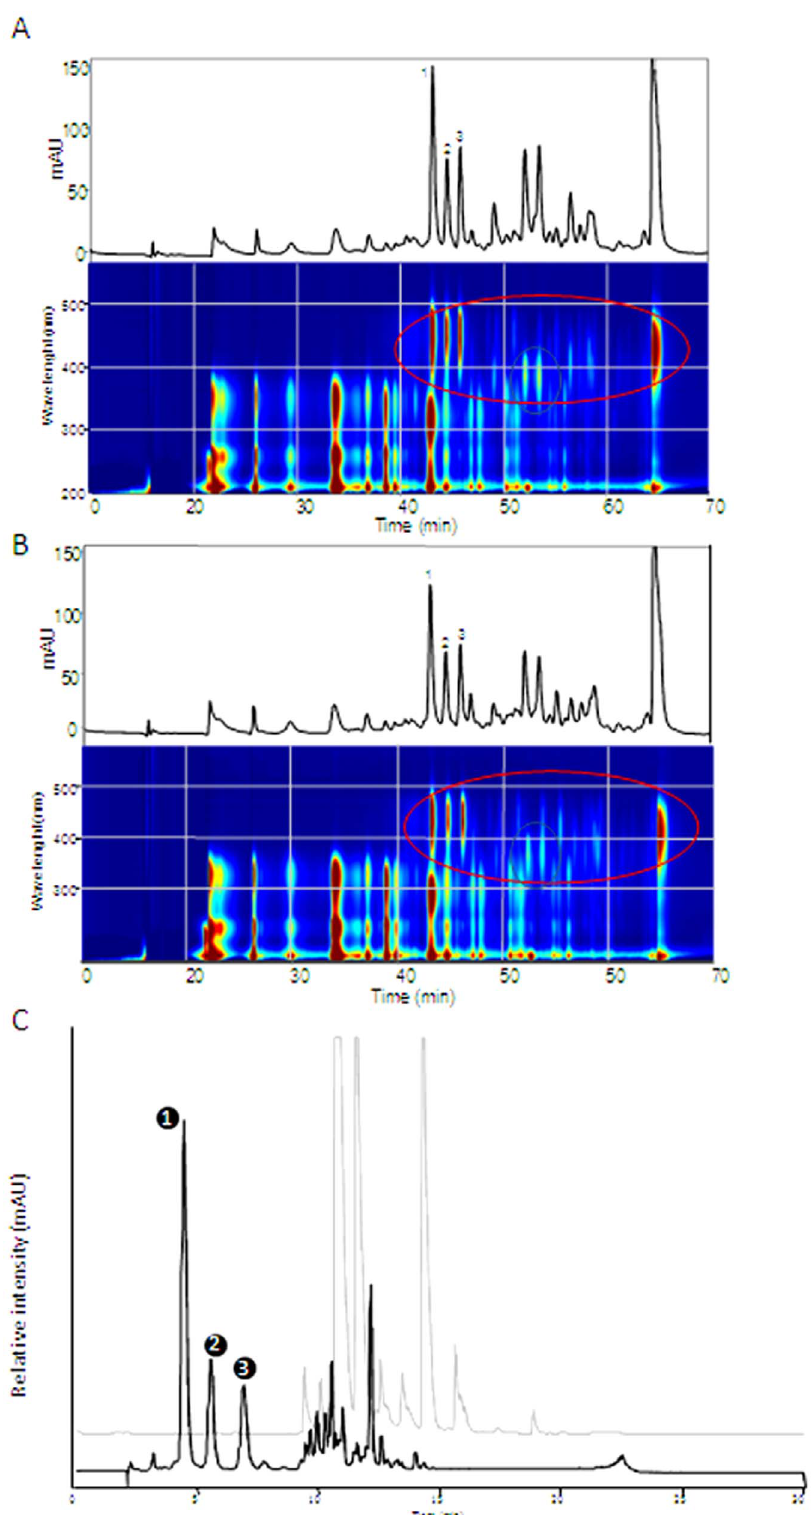
Figure 5. Heatmap showing changes of crocins levels comparing stigmas with tepals. Red indicates increased metabolite levels, and blue represents decreased levels (see colour scale bar).